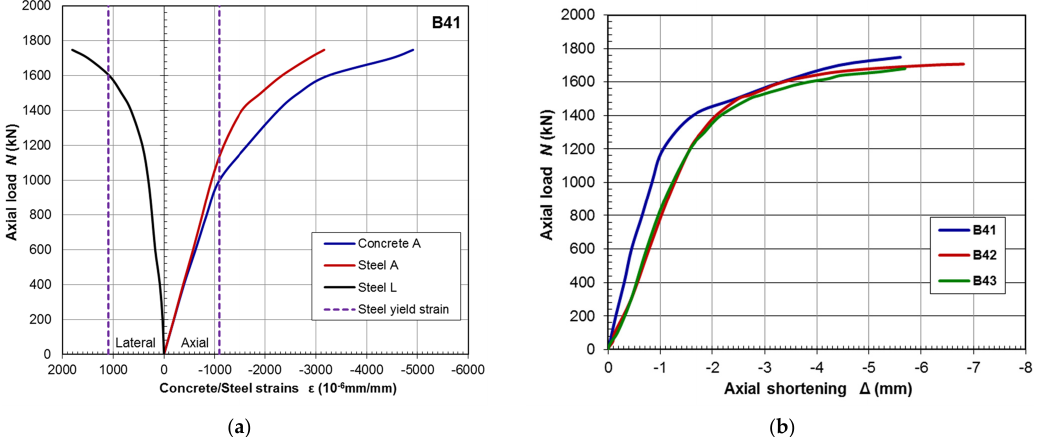
Figure 9. Measured axial load versus strains ( a ) and load versus deformation ( b ) relationships of the second group of strengthened specimens (B4x series).